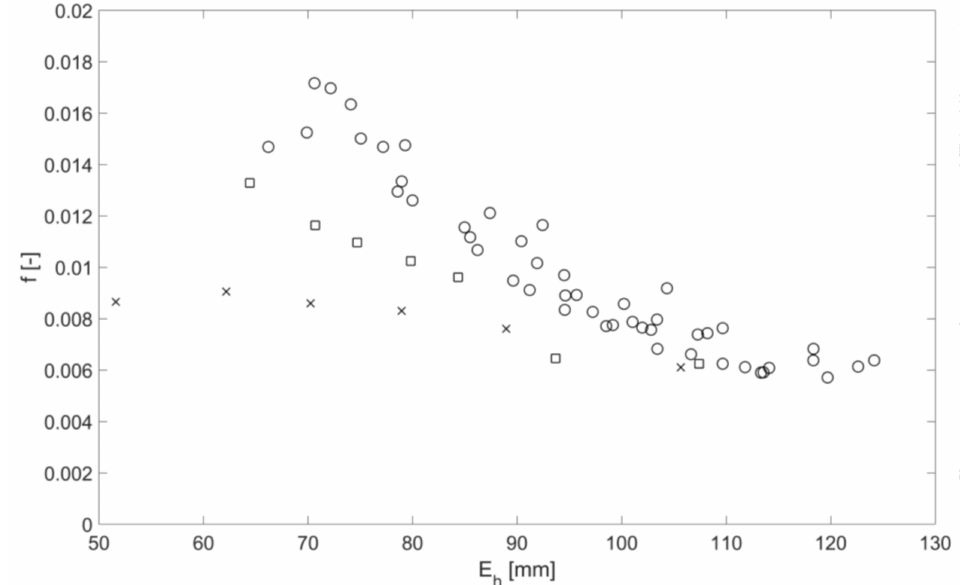
Figure 9. Friction factor as a function of the mean flow depth for three bed roughness types: clean pipe (cross), pipe with mesh (squares), pipe with spheres